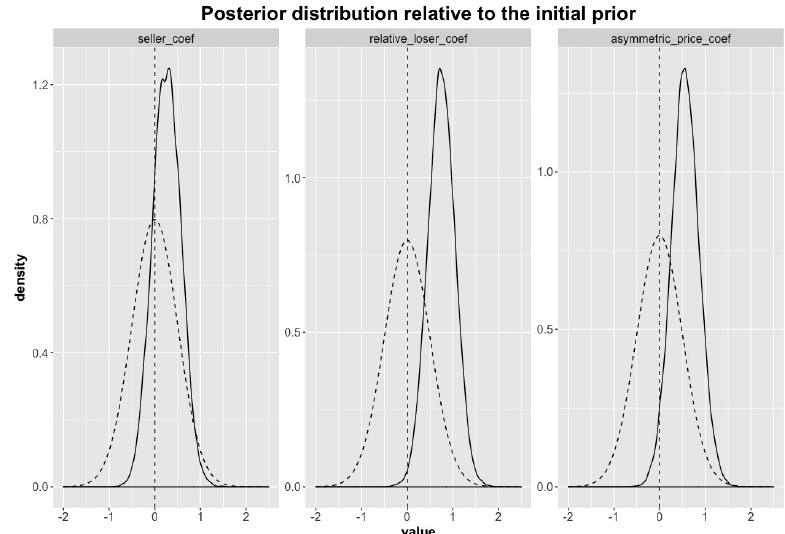
Figure 2. The distributions shown with dashed lines are the imposed effect prior, centered around 0. The solid line distributions show the posterior distribution, which is the updated effect distribution that conditions on the observed data.